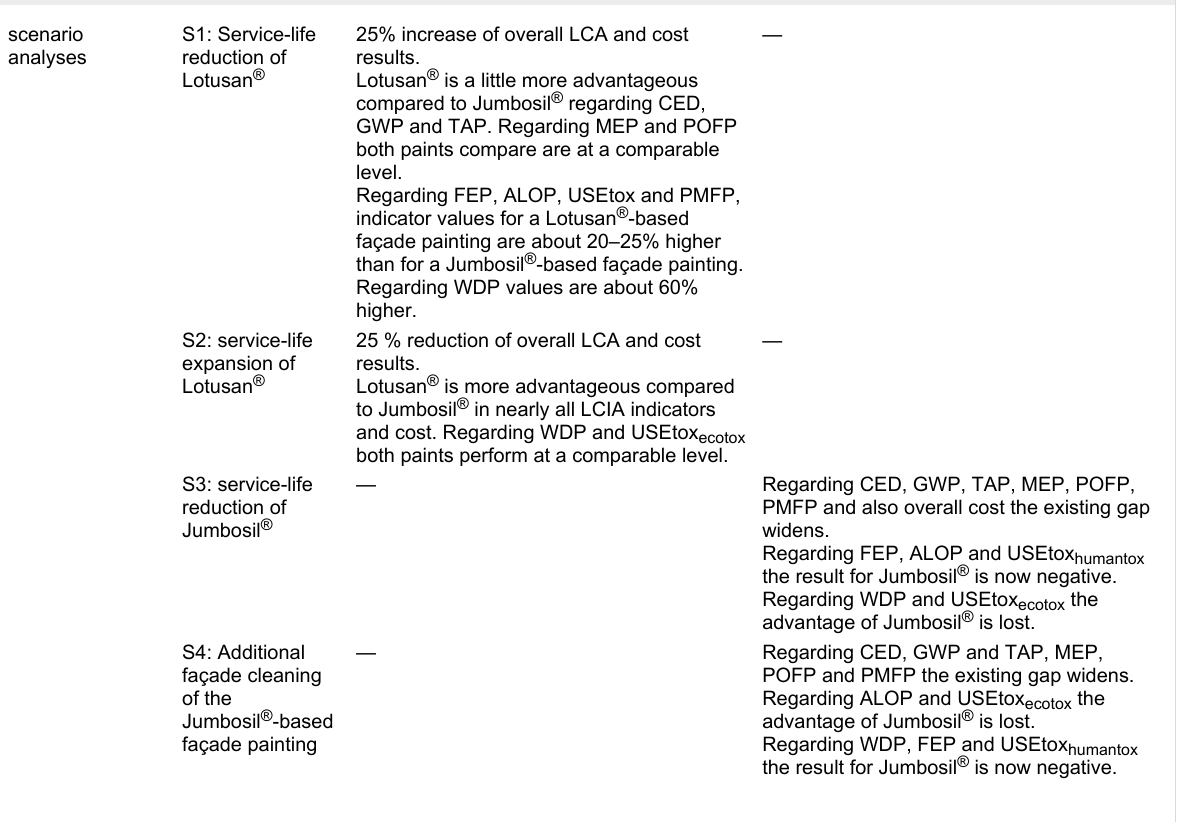
Table 4: Overview of the results for the individual analyses carried out within the product sustainability assessment. (continued) scenario